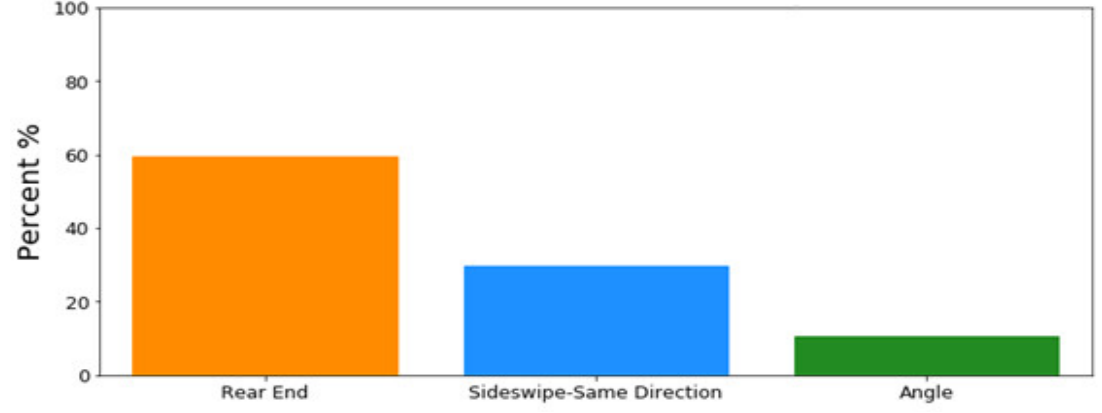
Figure 3. The distribution of multi-vehicle crash types.